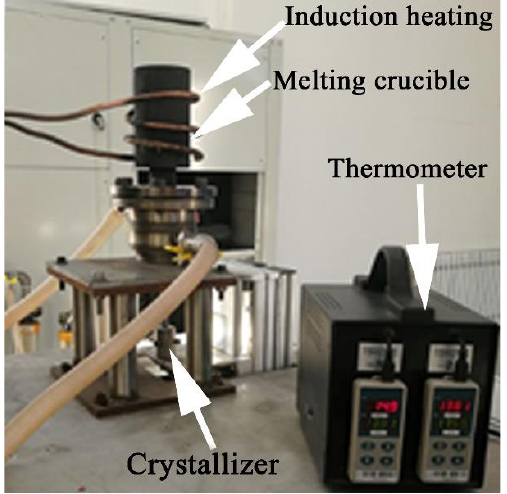
Figure 1. The illustration of HCCM continuous casting device.